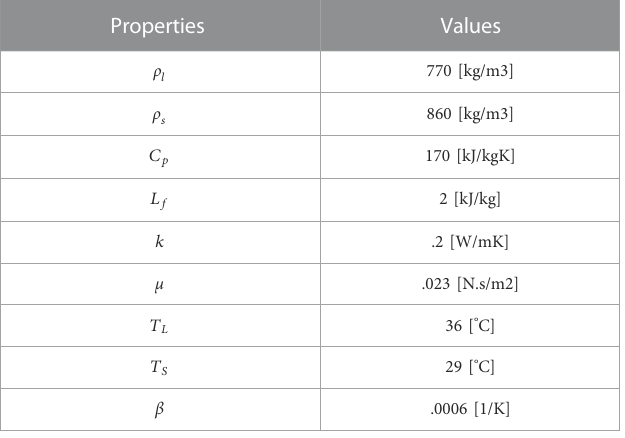
TABLE 1 Thermodynamic characteristics of the applied PCM (Rubitherm,